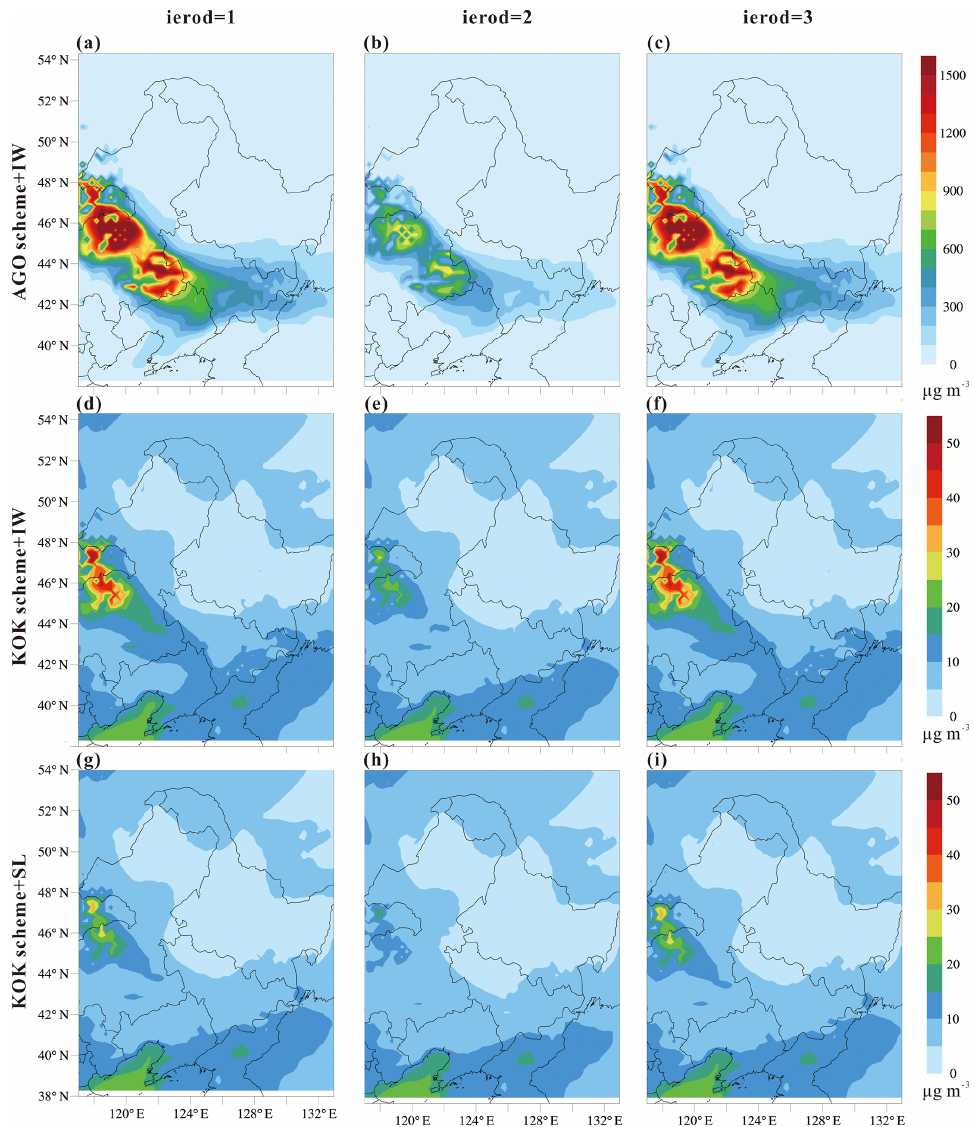
Figure 6. Daily mean PM 10 distributions in NEC on 5 May 2015 using AGO (with threshold friction velocity of IW) and KOK (with threshold friction velocity of IW and SL) with erodible fractions ierod = 1, ierod = 2, and ierod =